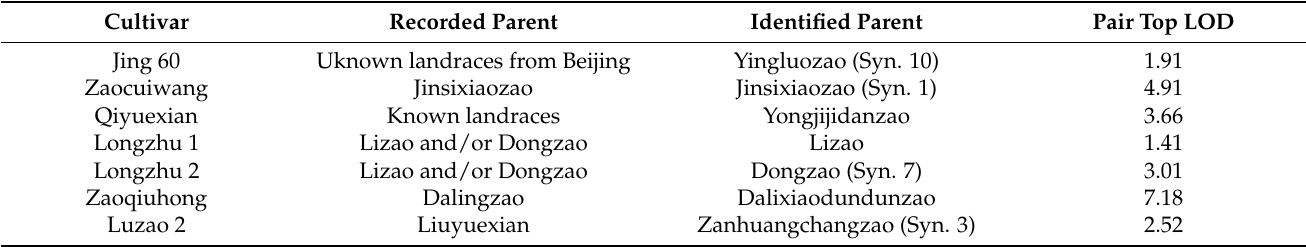
Table 5. Testing recorded parent—offspring relationship in jujube cultivars using 192 SNP markers. Cultivar Recorded Parent Identified Parent Pair Top LOD Yingluozao (Syn.